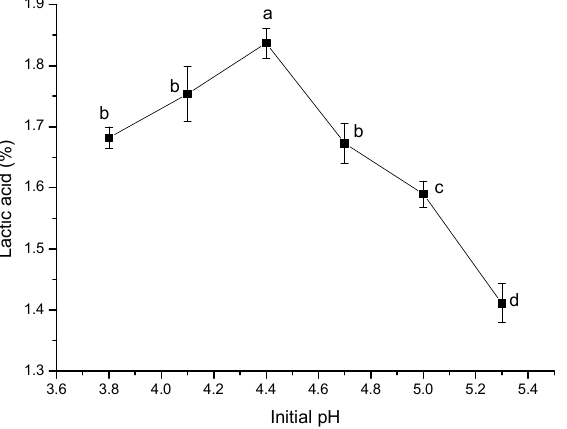
Figure 4. Initial pH single-factor experiments with Pediococcus acidilactici. Experiments were per- formed in triplicate (n = 3). Sites not sharing a common letter showed significant differences ( p < 0.05).